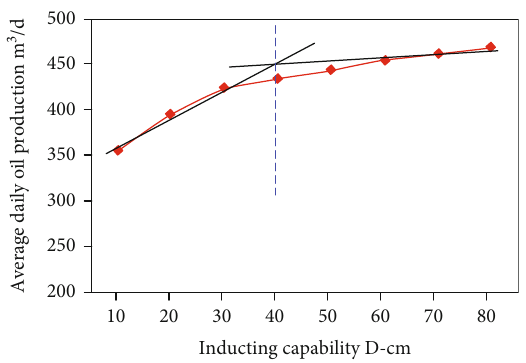
Figure 8: Average daily oil production versus